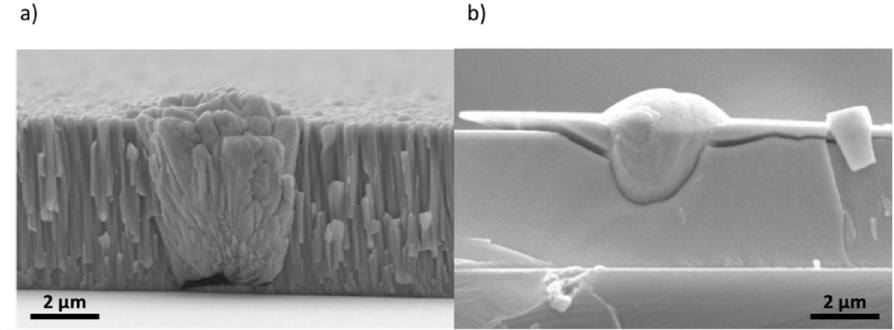
Figure 4. Magnetrons sputtering coatings cross-sectional images showing ( a ) throughout defect, ( b ) interrupted defect.